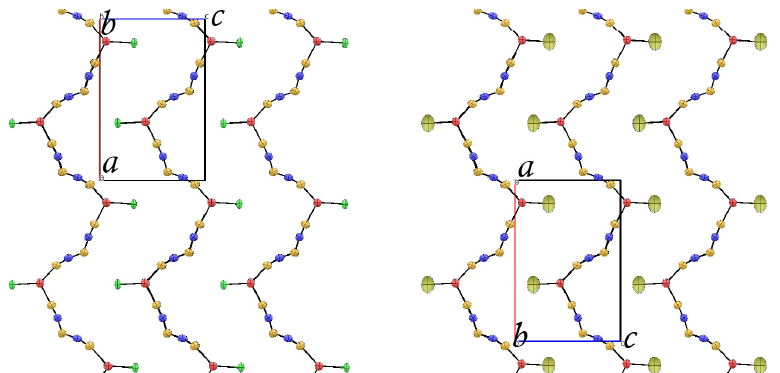
Figure 13. Perspective view of zigzag polymeric anion chains as obtained by structural refinements of X-ray data assuming either: κ -Cl ( Left ); or κ -Br ( Right ). View shows the ac plane. Copper, carbon and nitrogen are shown in red, blue and orange, respectively. Chlorine and bromine ligands on each copper atom are colored in dark and light green, respectively. All atoms are drawn with 50% probability ellipsoids of anisotropic thermal displacement parameters. Unit cell is marked as a rectangle.